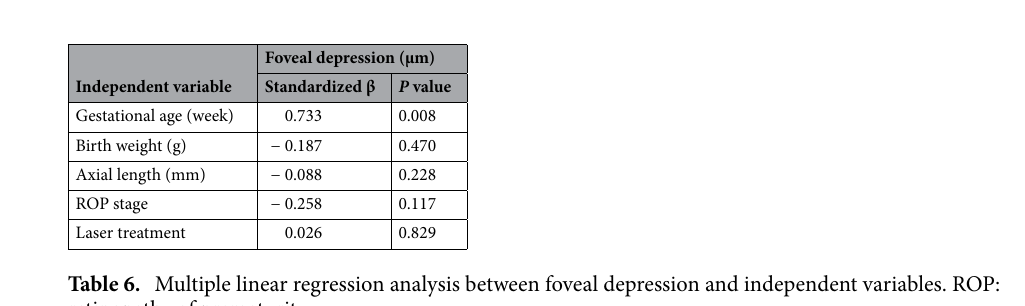
Table 6. Multiple linear regression analysis between foveal depression and independent variables. ROP: retinopathy of prematurity.